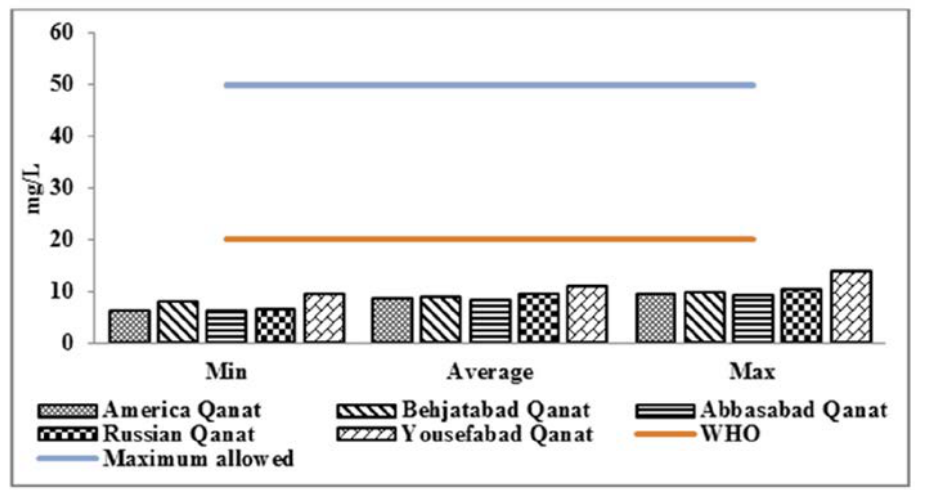
Fig. 8: NO3 level and its comparison with the WHO and the National Standard of Iran